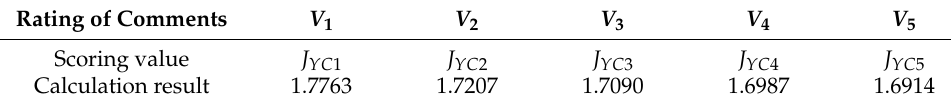
Table 6. The score value of the evaluation grade of the YC performance.